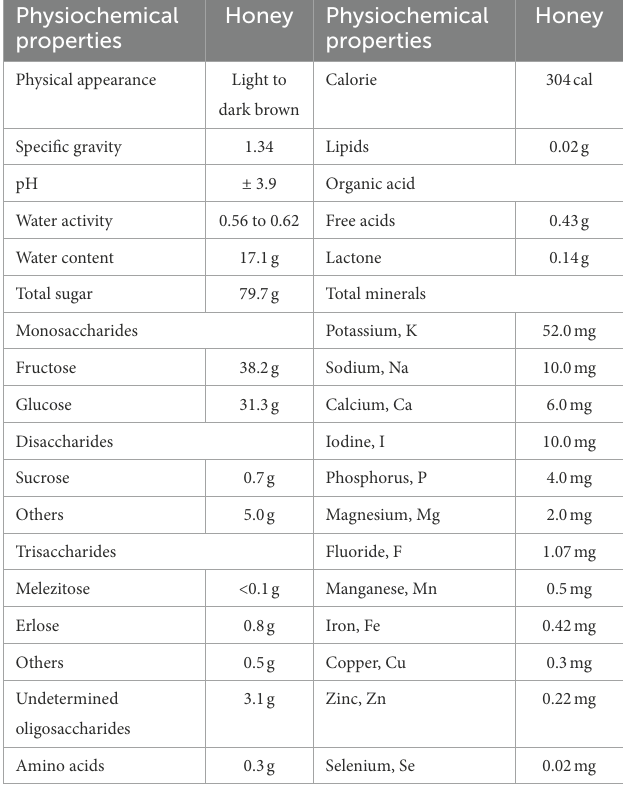
TABLE 1 Summary of the physiochemical properties of honey per 100 g (Terzo et al., 2020). Physiochemical